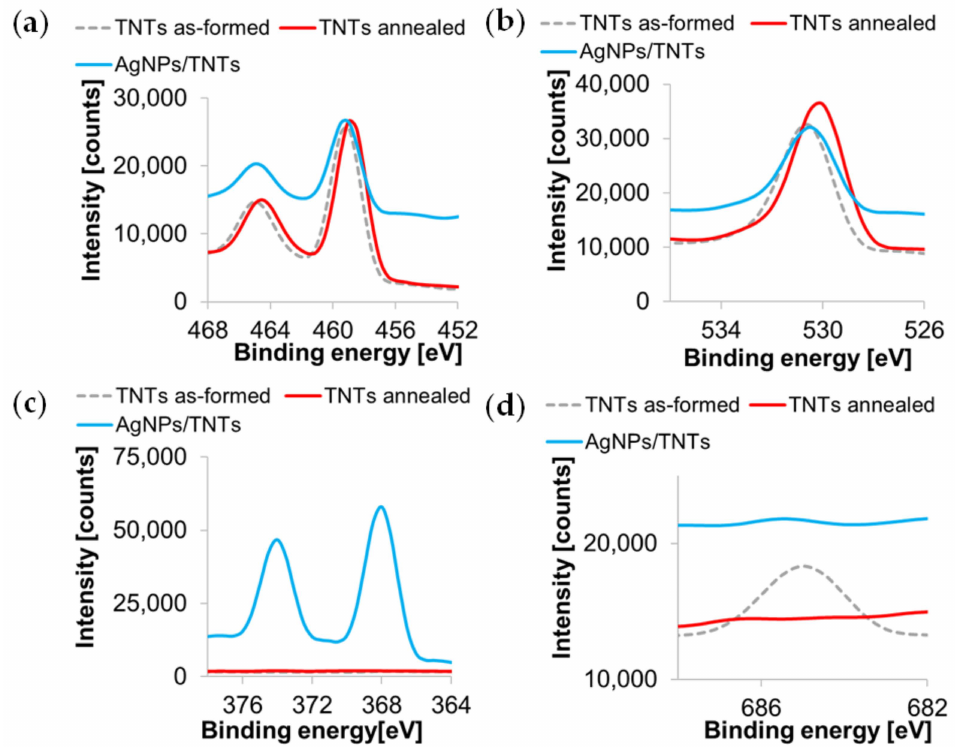
Figure 5. Ti 2p ( a ), O 1s ( b ), Ag 3d ( c ), and F 1s ( d ) XPS spectra of as-formed TNTs, annealed TNTs, and AgNPs/TNTs platform.